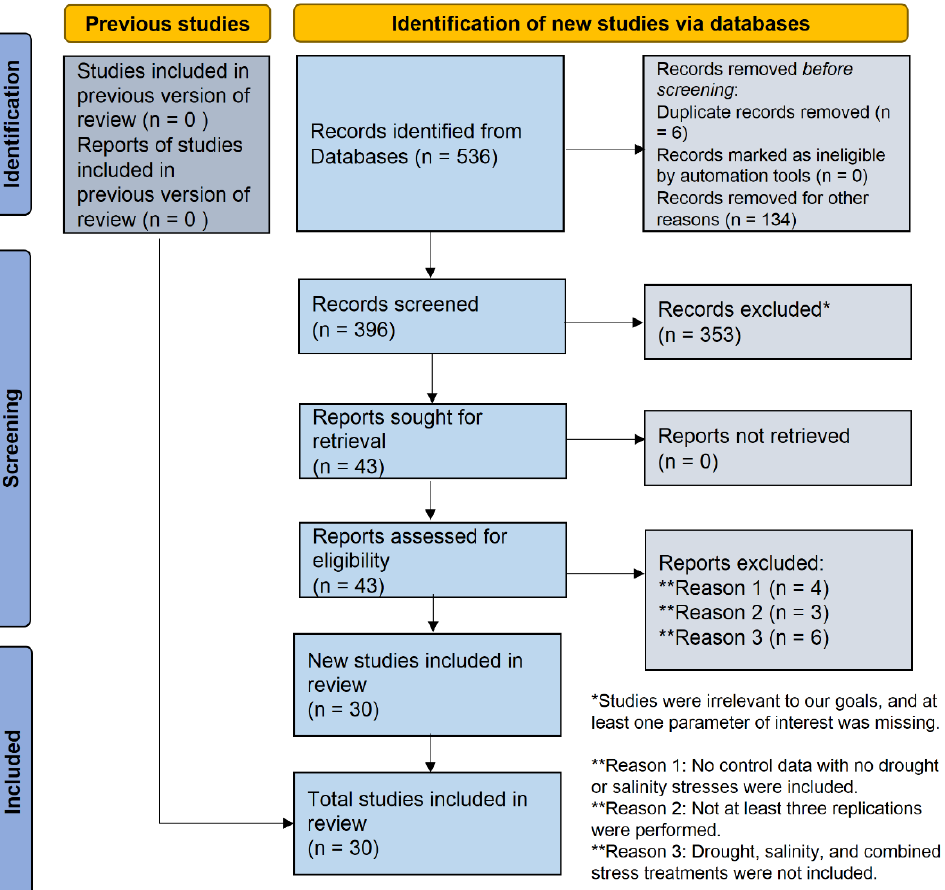
Figure 1. The systematic literature search flow diagram following Preferred Reporting Items for Systematic Reviews and Meta-Analysis (PRISMA). To synthesize and present findings in the current systematic review, we adhered to the PRISMA standards [37].